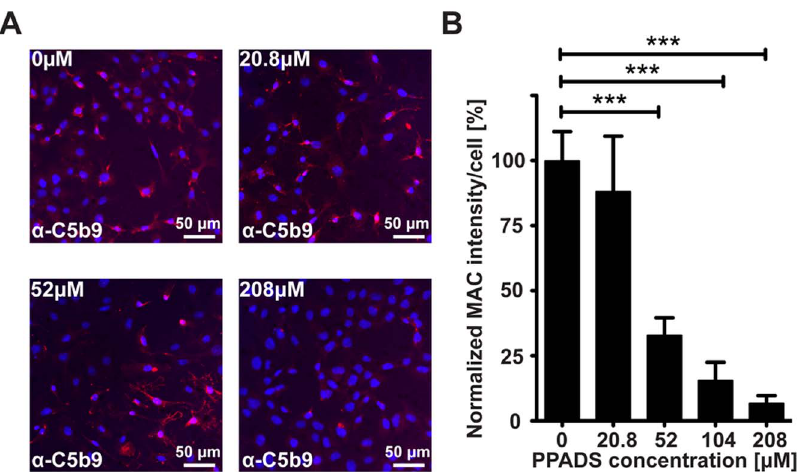
Figure 3. PPADS Inhibits Formation of MAC invitro . A ) Representative images of C5b9 labeling (red) of cells incubated with increasing concentrations of PPADS. Nuclei are counterstained with DAPI (blue). B ) Mean values 6 SEM of C5b9 staining intensity per cell at various concentrations of PPADS. Values represent cumulative data from 4 independent studies. Significant differences are indicated as capped lines between vehicle control (0.9% NaCl, 0 m M PPADS) and the various concentrations of PPADS (*** p , 0.0005, ** p , 0.005, * p , 0.05).